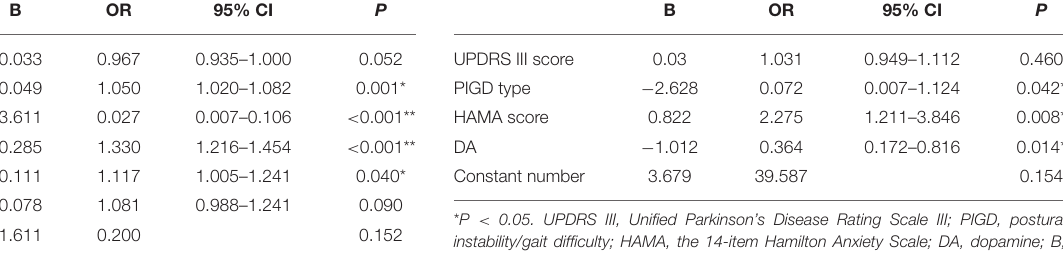
TABLE 6 | Logistic regression analysis of the relationship of DA in CSF and PD-D. B